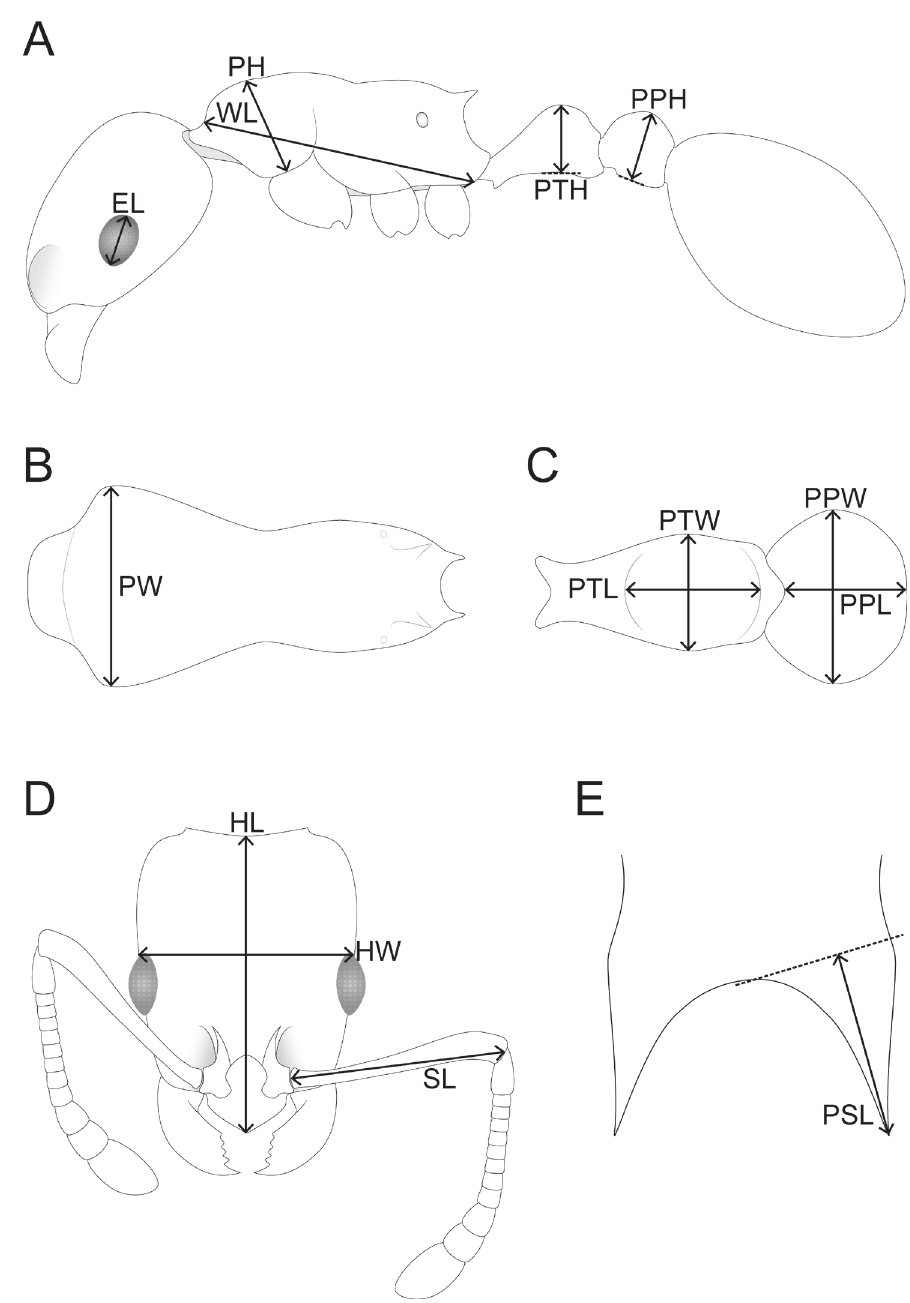
Fig. 1. Schematic line drawings of Nesomyrmex inhaca sp. nov., illustrating the measurements used. A . Body in profile with measuring lines for EL, WL, PH, PTH and PPH. B . Mesosoma in dorsal view with measuring line for PW. C . Petiole and postpetiole in dorsal view with measuring lines for PTL, PTW, PPL and PPW. D . Head in full-face view with measuring lines for HL, HW and SL. E . Dorsocaudal view of the propodeum with measuring line for